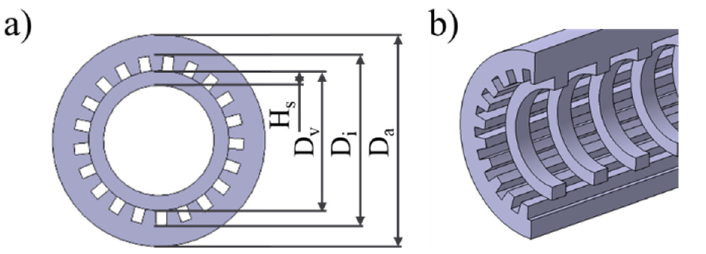
Figure 2. ( a ) Characteristic dimensions of wick sample and ( b ) support rings inside the grooved wick structures. Table 1. Grooved wick